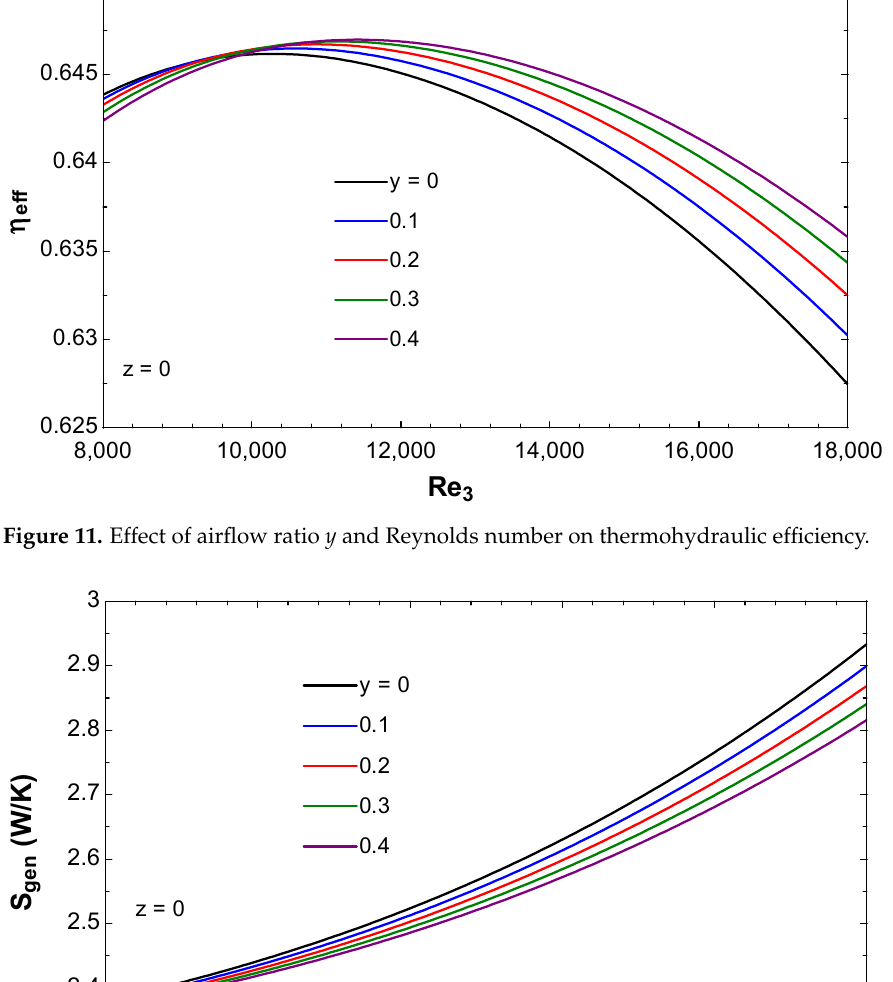
Figure 10. Effect of airflow ratio z and Reynolds number on entropy generation.